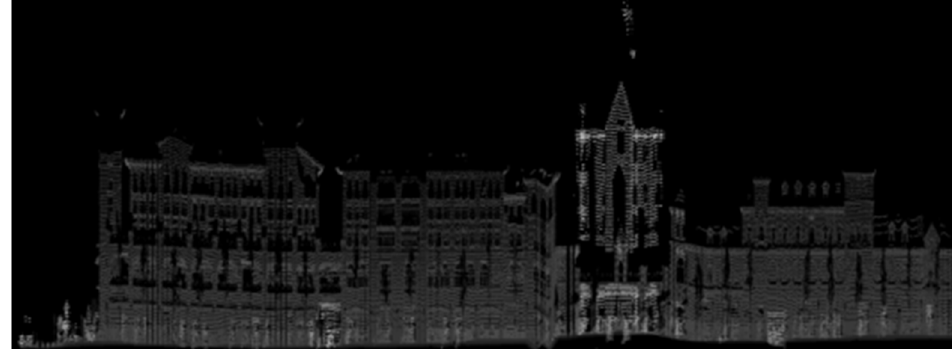
Figure 6. Original point cloud projection image.